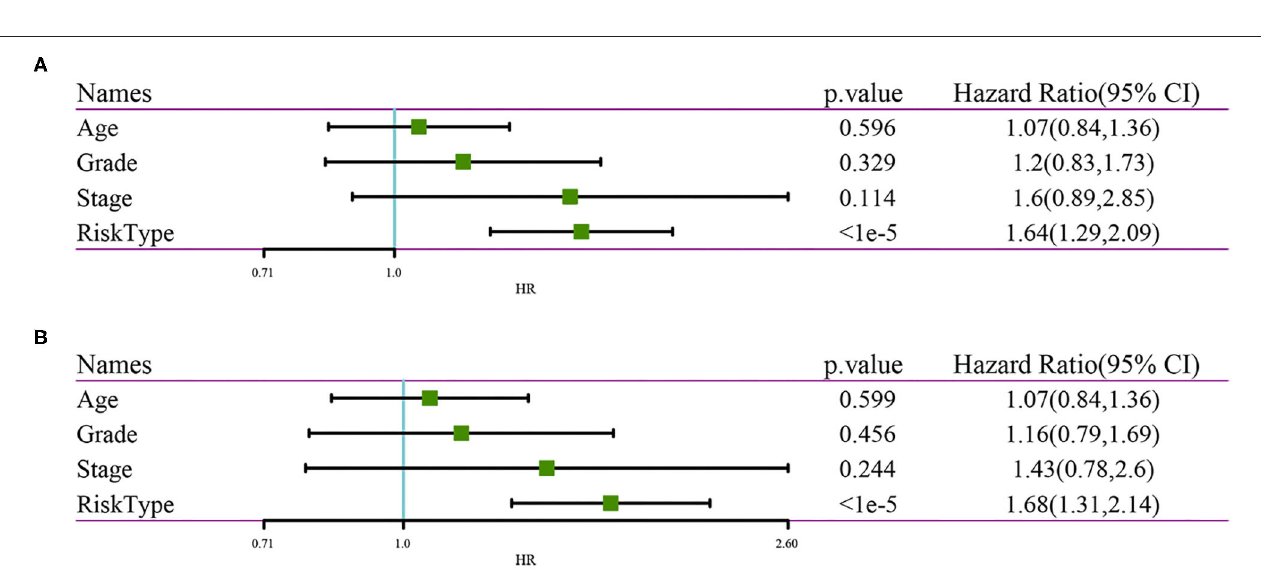
FIGURE 12 | (A) Clinical features and results of univariate analysis by RiskScore; (B) Clinical Features and results of multivariate analysis by RiskScore.